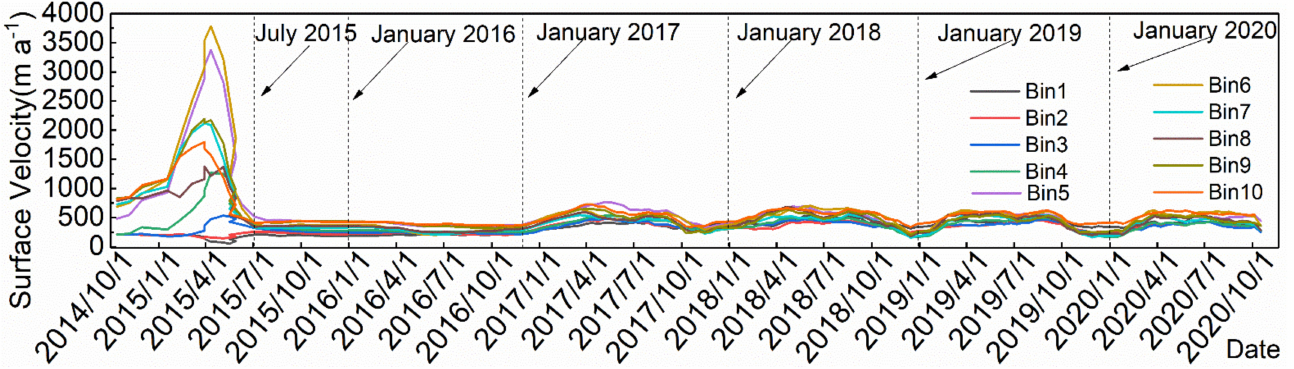
Figure 4. Surface velocity (mean values of the bins) at an interval of 12/18/24 from 13 October 2014 to 17 October 2020. Bin 1 to Bin 10 represents 10 sub-regions separated at 1 km equidistance along the centreline of terminus and west branch of Karayaylak